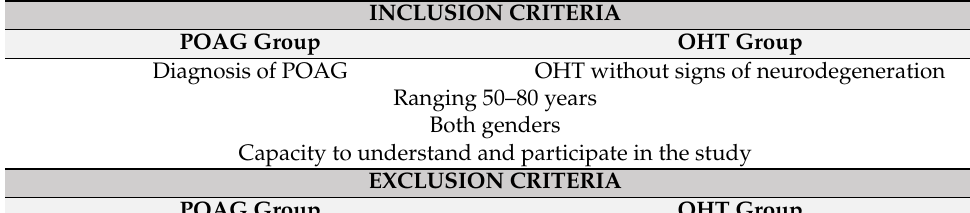
Table 1. Inclusion and exclusion criteria for the study participants. INCLUSION CRITERIA POAG Group OHT Group Diagnosis of POAG OHT without signs of neurodegeneration Ranging 50–80 years Both genders Capacity to understand and participate in the study EXCLUSION CRITERIA POAG Group OHT Group Other GLs different from POAG With signs of glaucoma neurodegeneration <40 or >80 years